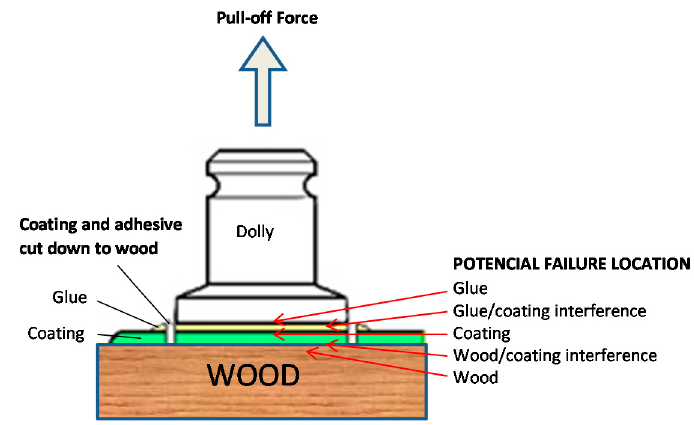
Figure 1. Classification of failure location for the Pull-off strength test.